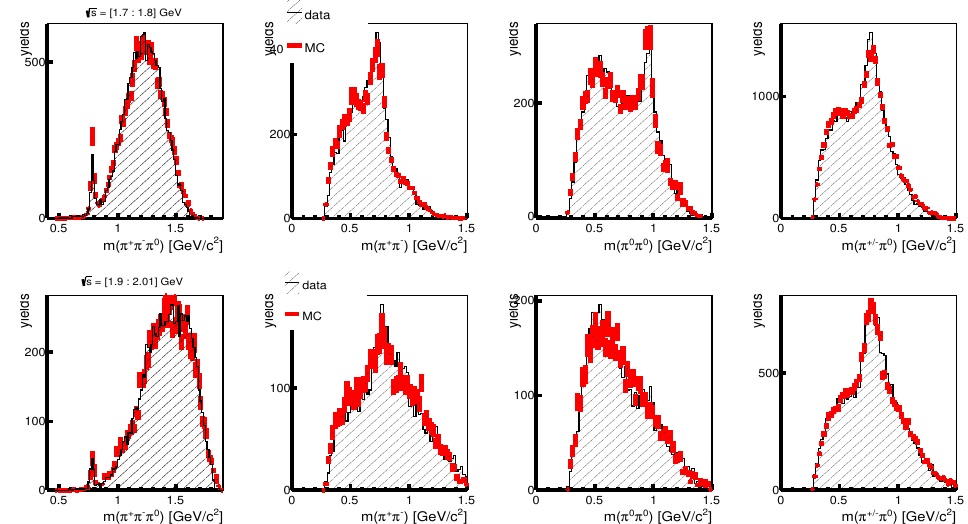
Figure 4. The data-MC comparison of the π + π − π 0 , π + π − , π 0 π 0 and π ± π 0 mass spectra for the process e + e − → 2 π 0 π + π − in the energy ranges